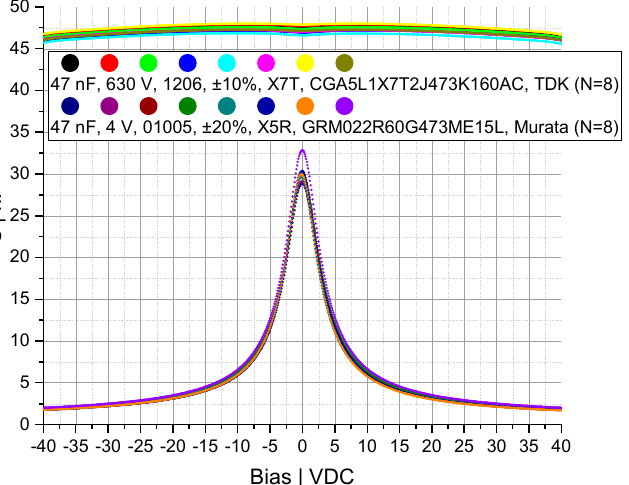
Figure 5. Measured capacitance C according to the bias voltage of the capacitor CGA5L1X7T2J473K160AC and GRM022R60G473ME15L at a frequency of 360 kHz and 400 kHz, respectively (N=8).